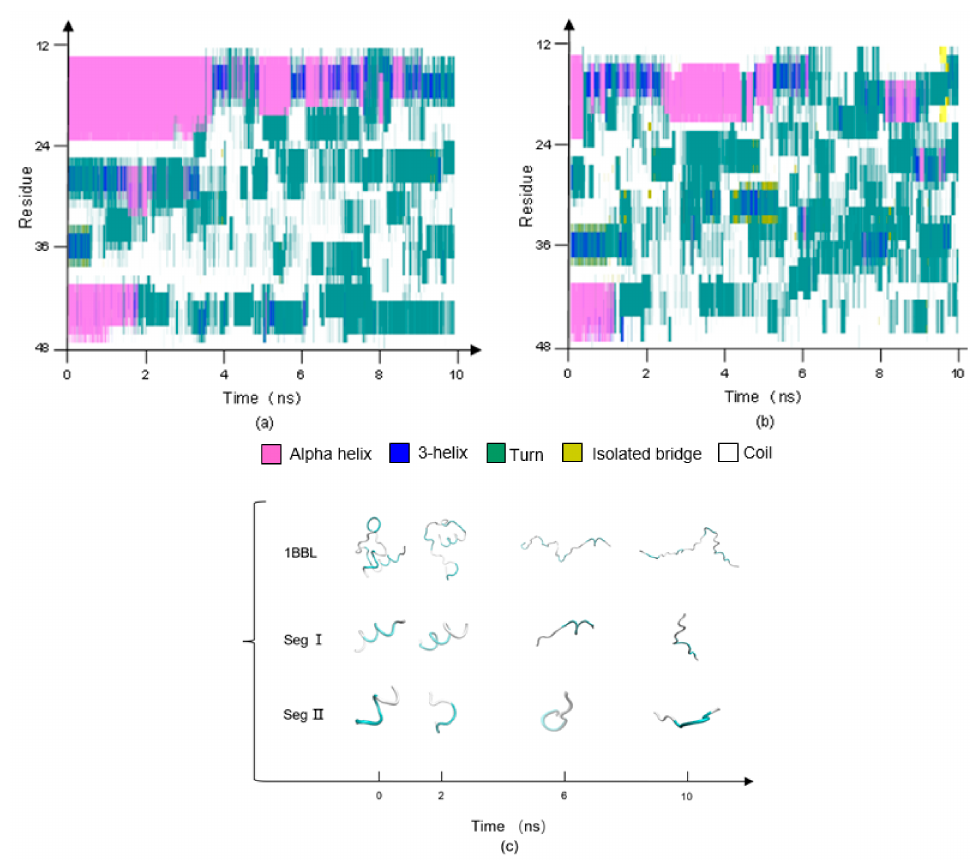
Figure 4. (Color online) Stride evolution of secondary structures of the protein 1BBL exposed in the oscillating electric fields with a frequency of ( a ) 1000 MHz, ( b ) 2000 MHz and ( c ) typical conformation of 1BBL and its segments during the simulation process in the condition of